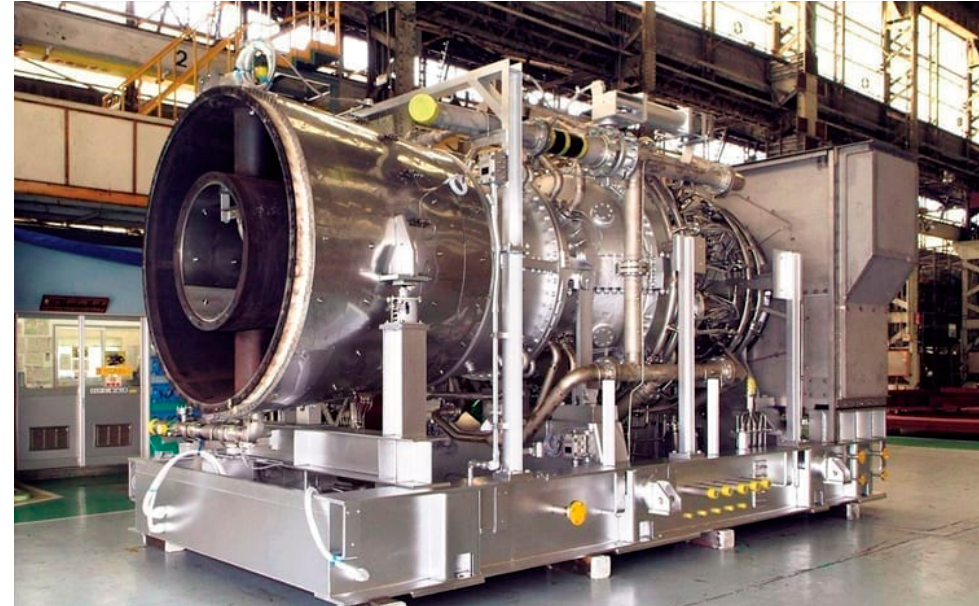
Figure 6. Fully ammonia, 40 MW (H-25 series) gas turbine developed by Mitsubishi [49].